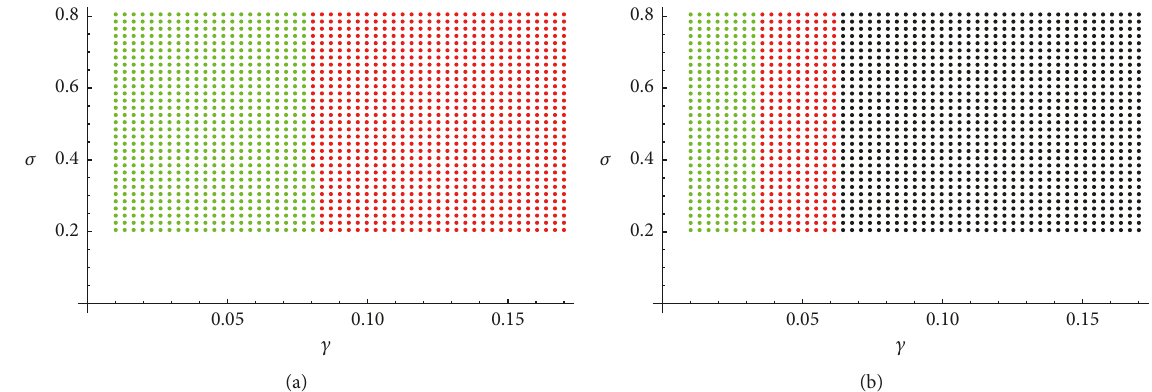
Figure 3: Stability features regarding the critical (green) and the zero (black and red) regions . Green denotes the negative slope of the real part of the complex eigenvalues versus 𝛽 , around 𝛽 cr , red indicates the existence of unstable endemic equilibria for 𝛽 ∈ (𝛿,1) , and black outlines the pairs (𝛾, 𝜎) for which no endemic equilibria arise in the whole range (0,1) for 𝛽 . The parameters are defined as 𝑟 = 10 −4 , 𝛼 = 10 −4 , 𝜀 = 10 −3 , and 𝑚 = 0.5 and (a) 𝑠 = 1.2 and (b) 𝑠 = 1.6